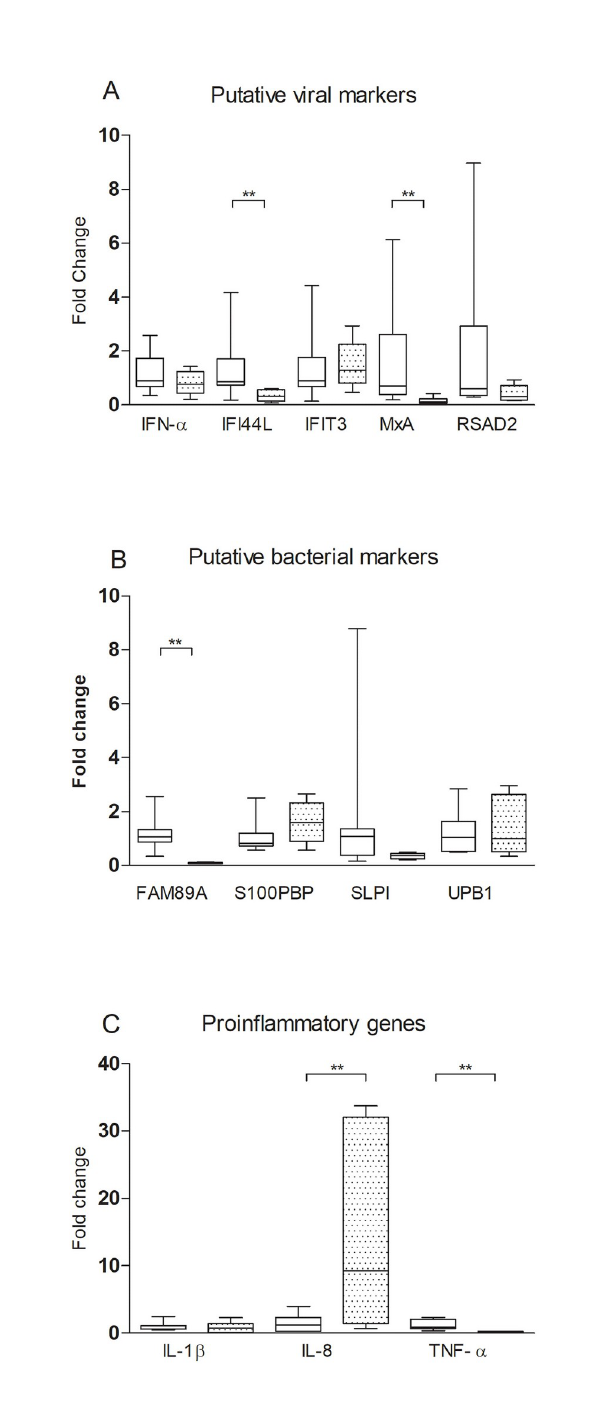
Fig 2. Expression of potential markers in A . pleuropneumoniae infected pigs. The Fold change denotes the expression of potential marker genes in SPF pigs (n = 11) and pigs infected with A . pleuropneumoniae (n = 6) normalized to the geometric average expression of the three reference genes RPL32 , GAPDH and YWHAZ . The expression in each pig was calibrated to that of the average expression in the SPF pigs and is shown as box plots. � p < 0.05, �� p <